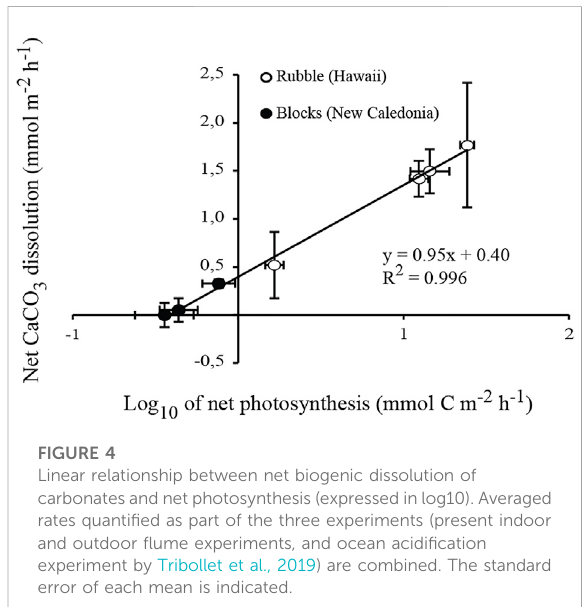
FIGURE 4 Linear relationship between net biogenic dissolution of carbonates and net photosynthesis (expressed in log10). Averaged rates quanti fi ed as part of the three experiments (present indoor and outdoor fl ume experiments, and ocean acidi fi cation experiment by Tribollet et al., 2019) are combined. The standard error of each mean is